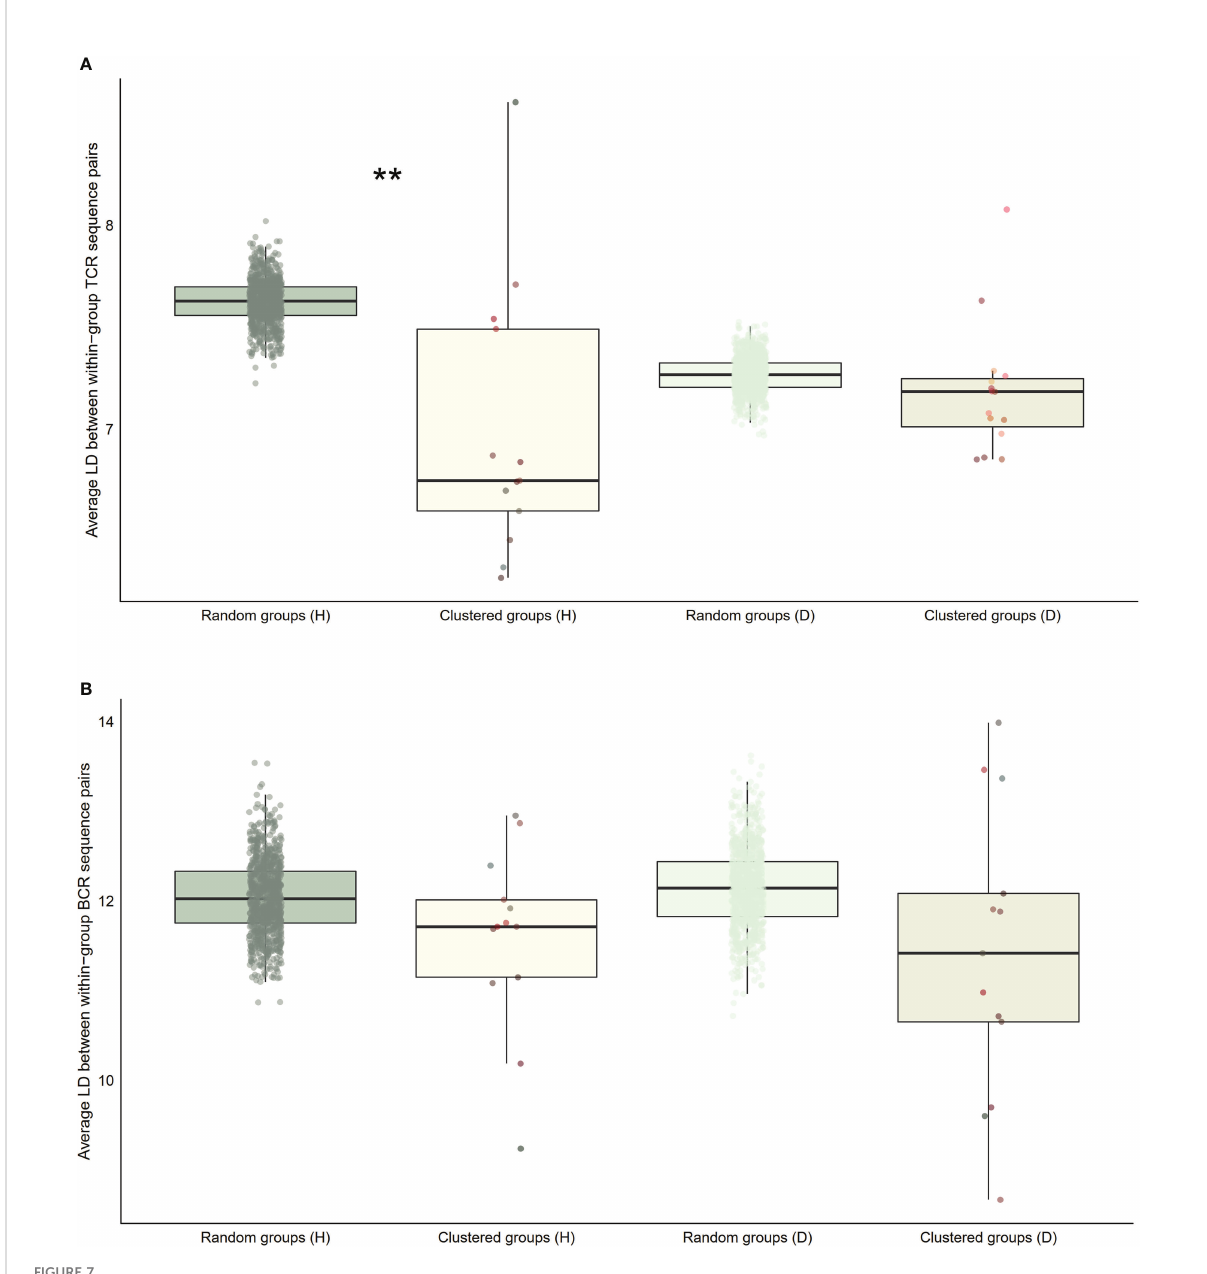
FIGURE 7 Distribution of average within-group pairwise Levenshtein distances for selected clusters of public BCR and TCR amino acid sequences compared to random groups of public BCR and TCR amino acid sequences. (A) Boxplot of averages of Levenshtein distance (LD) between TCR amino acid sequence pairs from healthy (H), and disease (D) clusters compared with averages of LD between TCR amino acid sequence pairs from randomly selected public T cell clonotype groups (B) Boxplot of averages of LD between BCR amino acid sequence pairs from healthy (H), and disease (D) clusters compared with averages of LD between BCR amino acid sequence pairs from randomly selected public B cell clonotype groups. Dots represent averages of each cluster or random group. P -values are from Kolmogorov-Smirnov tests for difference of two distributions, i.e. averages of random groups of amino acid sequences and averages of clustered clonotype sequences. ** P -value< 0.005. * P -value<